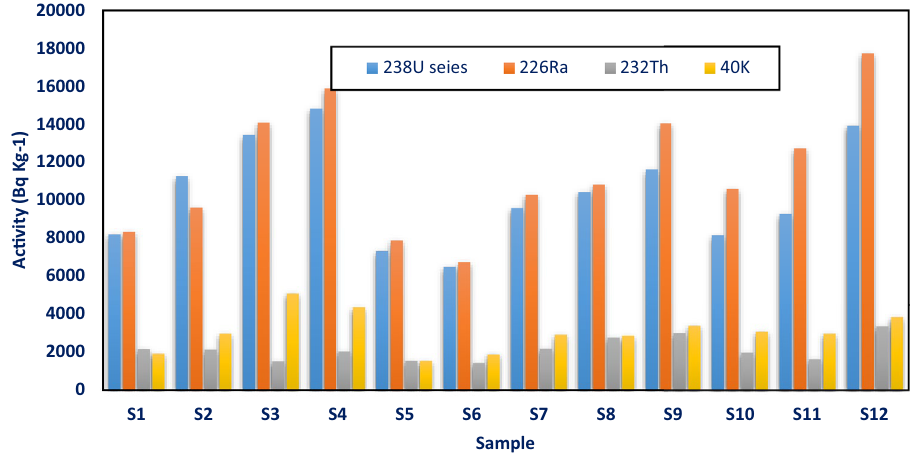
Fig. 3 Distribution of activity concentrations for different radionuclides in (Bq kg −1